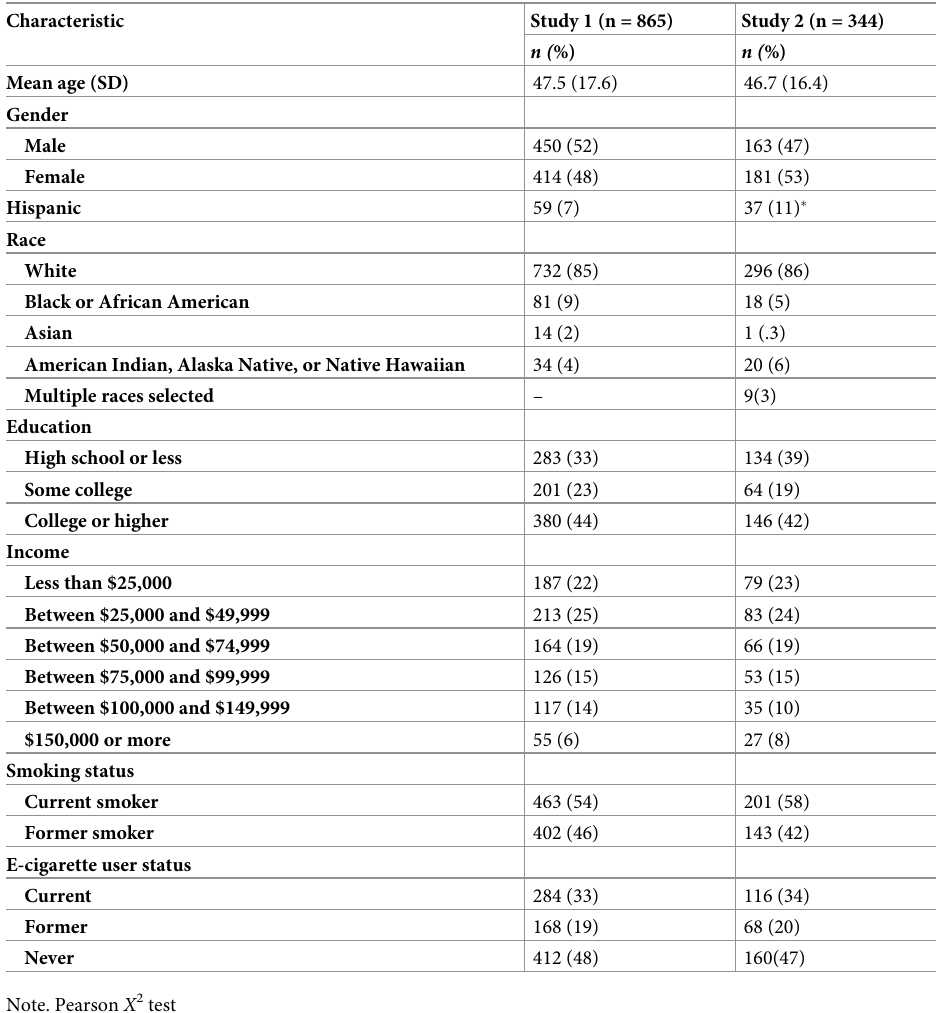
Table 1. Number and percentage of participants with various demographic